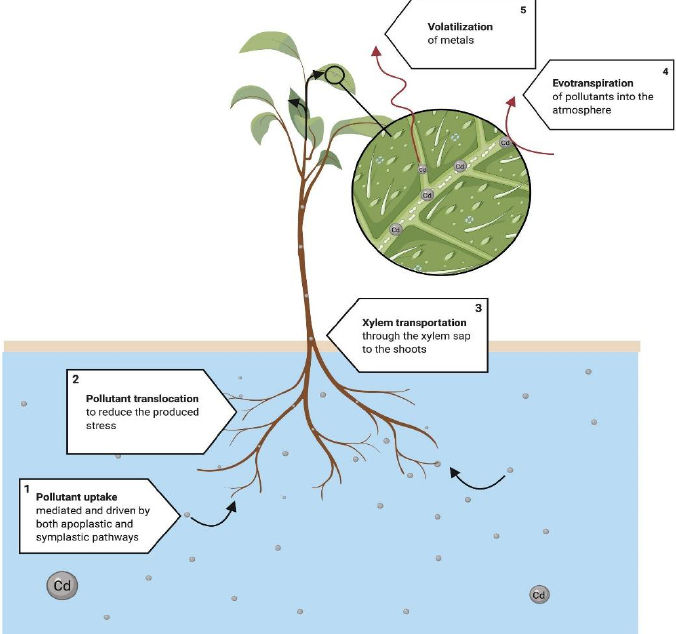
Figure 7. Proposed mechanism of phytovolatilization. (1) The process begins with the uptake and mobilization of the pollutant in the roots. (2) At the same time, the translocation of some ions, mainly metals, starts to reduce the produced stress in plant tissues. (3) The rest of the pollutants are transported to the photosynthetic area and start two main processes: (4) the evapotranspiration acts similarly to a vacuum to extract, in the presence of water, the pollutants and transport them into the atmosphere; meanwhile, (5) the combination of temperature and UV rays volatilizes the pollutants near the stomata of the leaves, mobilizing a great portion of the pollutants into the atmosphere, but transformed into less ecotoxic components/metabolites [130]. Table 2. Different processes in the root-microorganism association during phytoremediation of HMs in